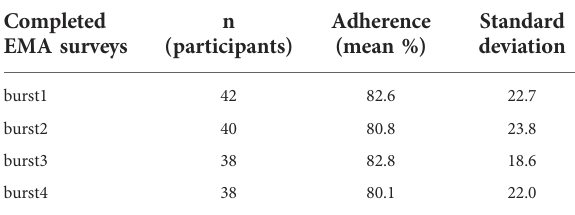
TABLE 4 Adherence rates across bursts in subsample of participants that contributed data to burst 1 and/or 2 and burst 3 and/or 4. Completed EMA